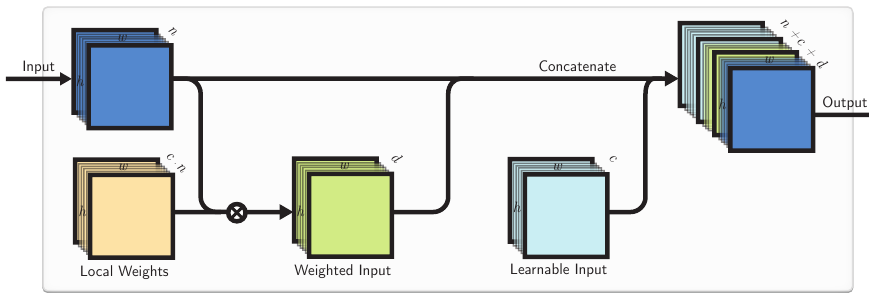
Figure 3. The combined approach.